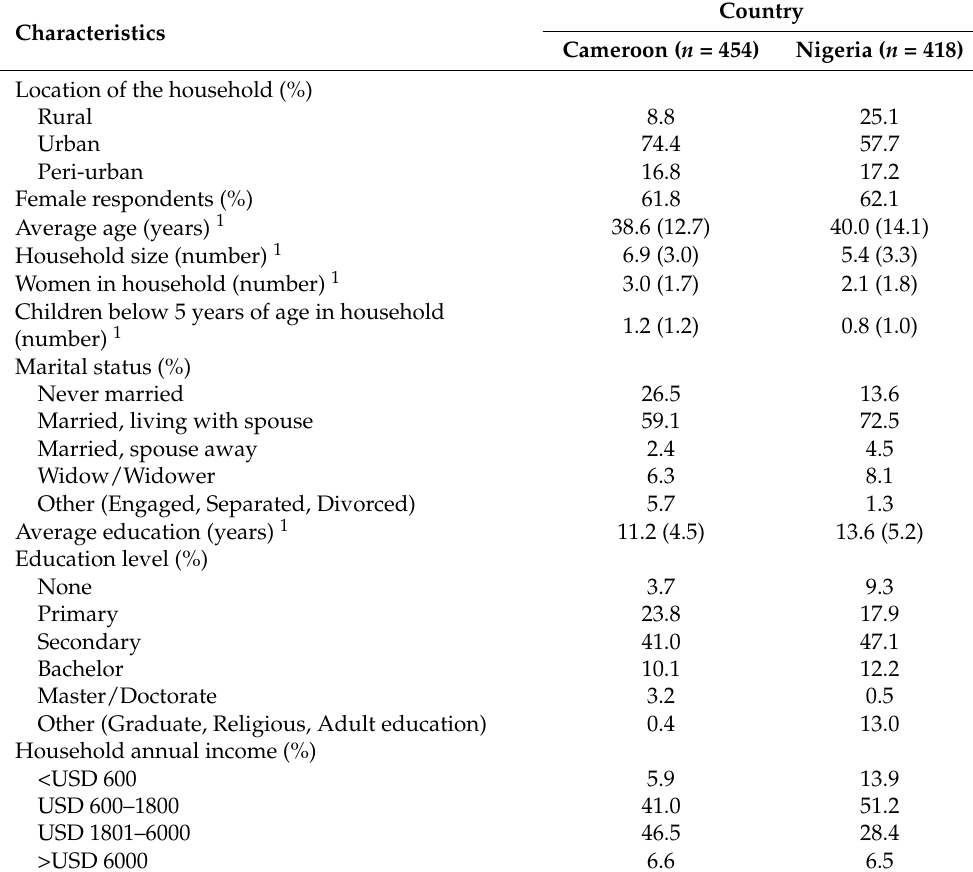
Table 1. Socioeconomic characteristics of the